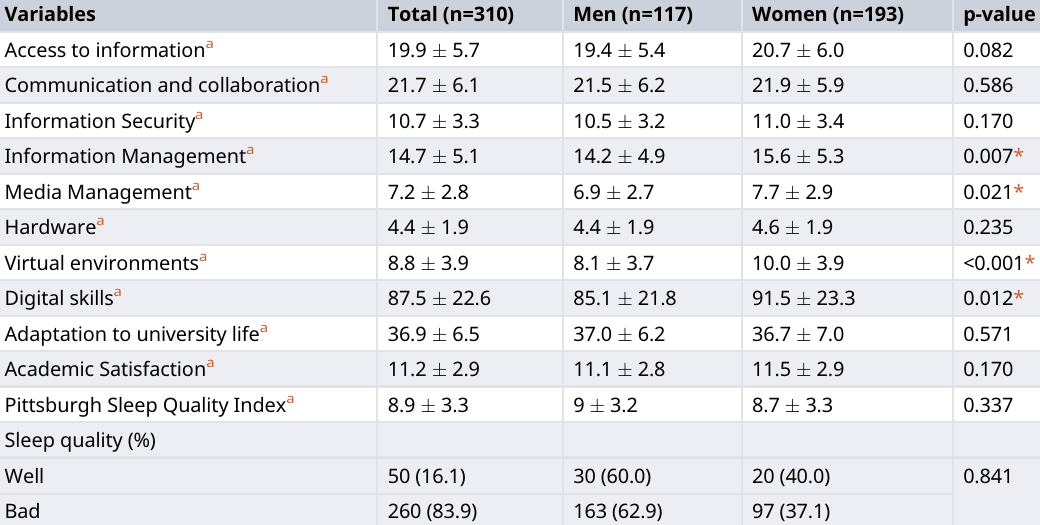
Table 2. Digital skills, adaptation to university life and academic satisfaction of medical students.